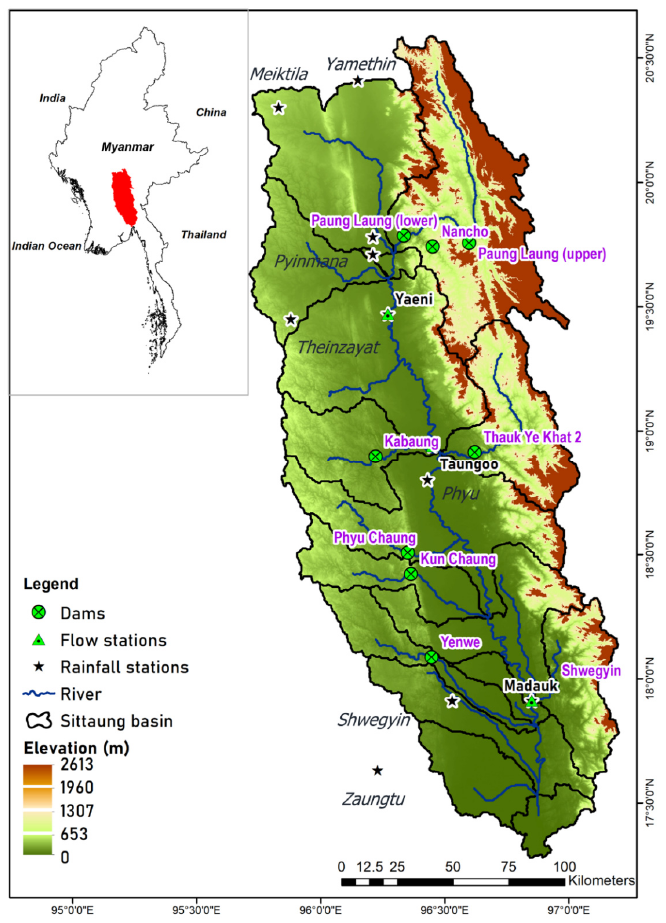
Figure 1. Sittaung river basin and the location of rainfall, discharge stations, and dams in the study area.